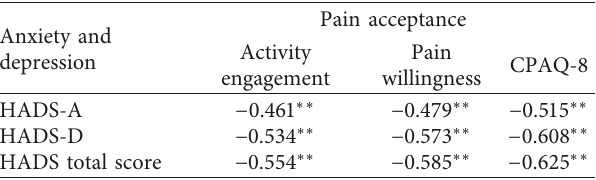
Table 2: Correlations between CPAQ-8 and